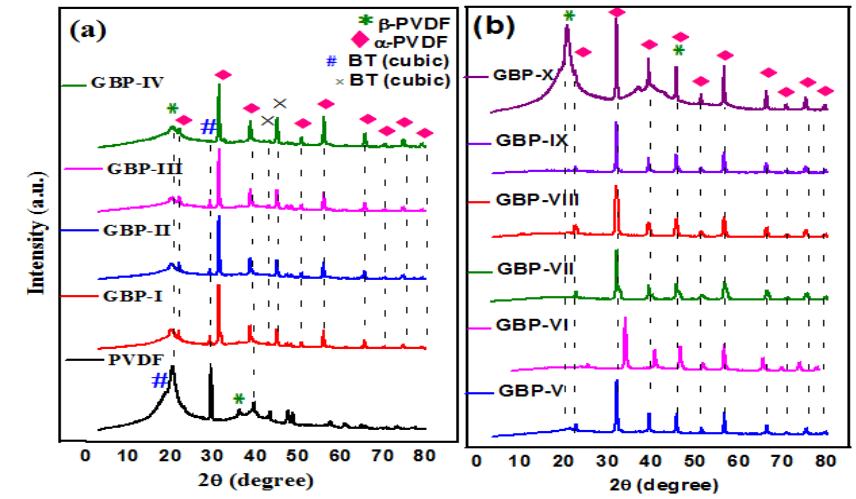
Figure 3. X-ray diffraction (XRD) pattern of ( a ) neat polyvinylidene fluoride (PVDF) and G/BT/PVDF nanocomposite films with different graphene fraction ( b ) G/BT/PVDF nanocomposite films with